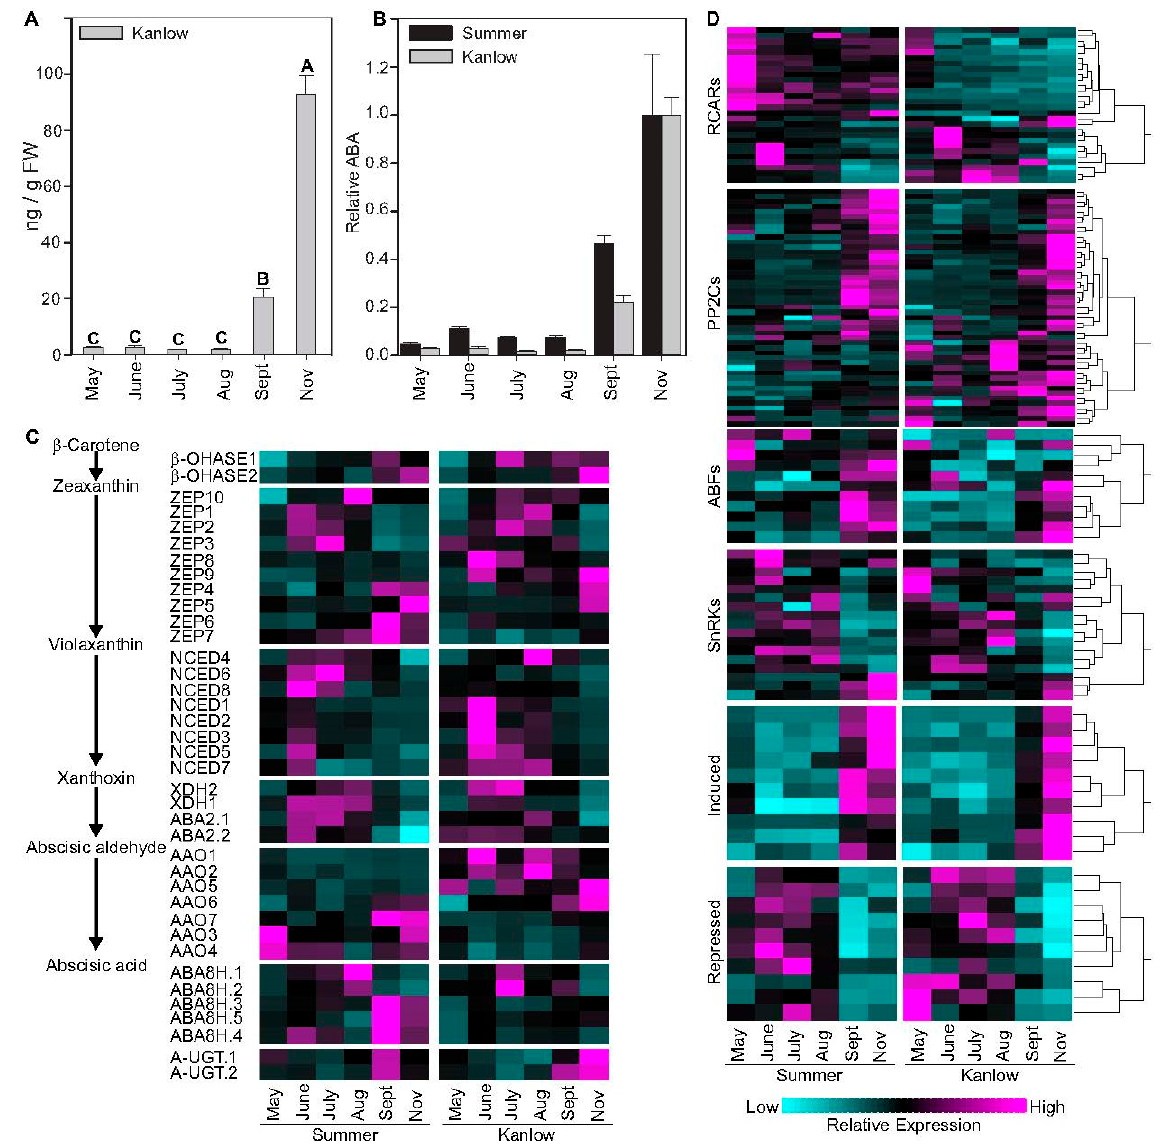
Figure 1. Abscisic acid (ABA) levels and changes in expression patterns of ABA-related genes. ( A ) ABA content in Kanlow rhizomes at each sampling date. Letters over each bar denote statistical significance. Error bars represent standard error. ( B ) Relative ABA levels in Summer (black bars) and Kanlow (grey bars) at each sampling date. ABA data for Summer rhizomes have been previously published [11]. Error bars represent standard error. ( C ) Abbreviated ABA pathway (left) and heat map of genes encoding the various ABA biosynthetic enzymes at each sampling date for Summer and Kanlow rhizomes. ( D ) Changes in expression of genes encoding proteins that are associated with ABA at each sampling time. Gene abbreviations as provided in the text. Cyan is low expression and magenta is high expression. Full list of genes is provided in Supplementary Data S1.